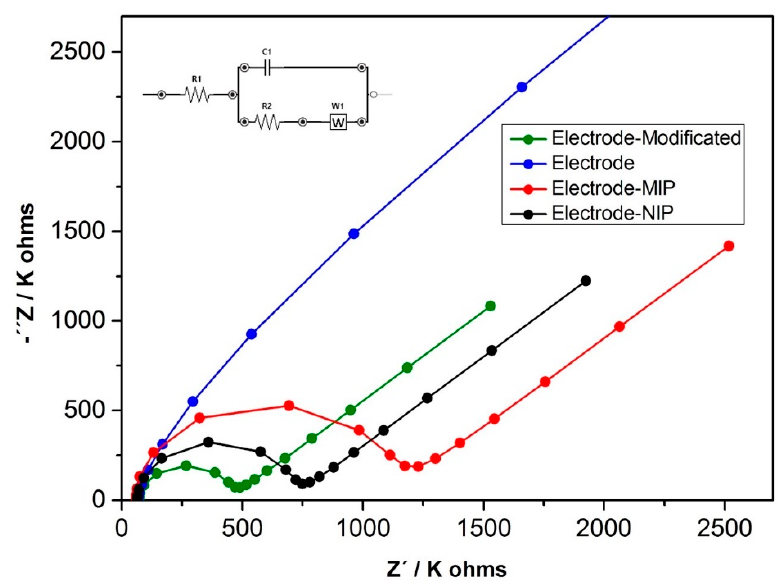
Figure 3. Electrochemical impedance spectroscopy (EIS) to screen-printed electrodes. Bare Gold Electrode (Blue), MIP-Electrode (Red), NIP-electrode (Black), and electrode chemically modified with monomer (green).